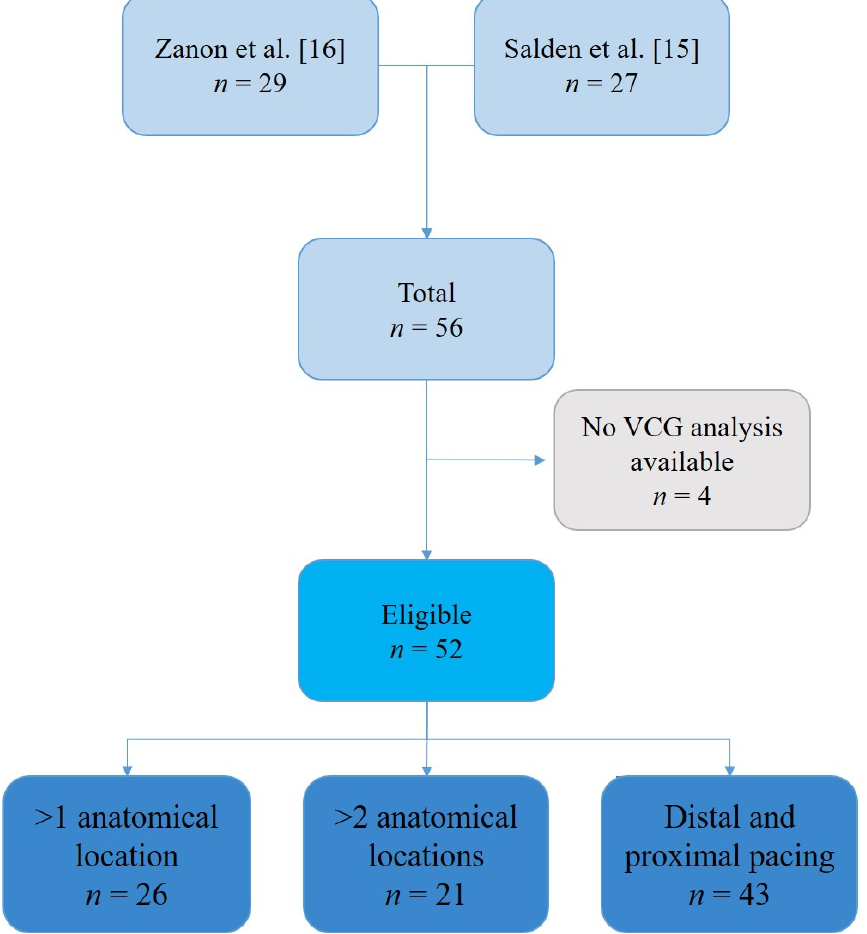
Figure 2. Flowchart of patients. A total of 56 patients were analyzed in previous studies. Four patients in which VCG analysis was not available were excluded, bringing the number of eligible patients to 52. Patients were analyzed depending on the number of different intra-individual pacing measurements. VCG = vectorcardiogram.